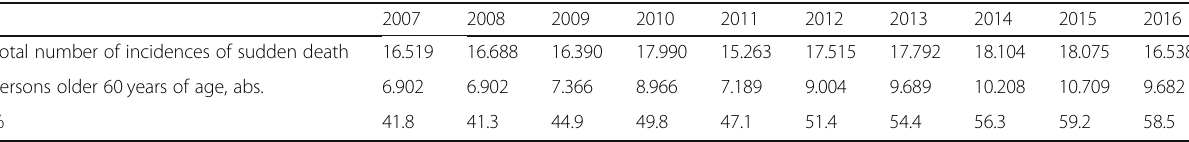
Table 4 Sudden death rates in the over-60s age